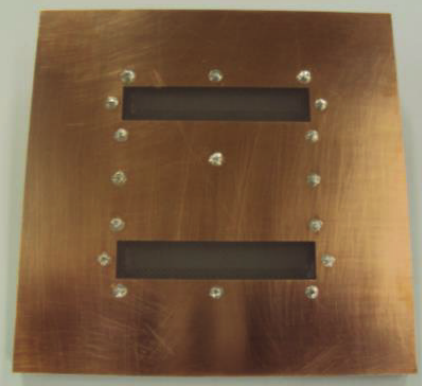
Figure 23: A picture of the SIW antenna prototype (based on A